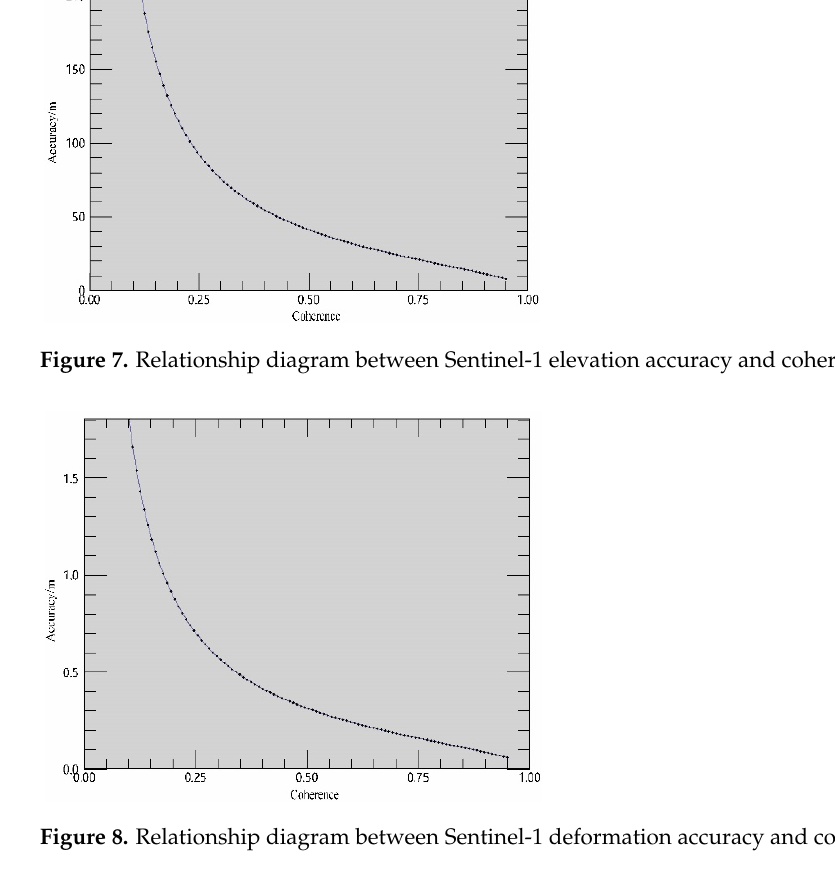
Figure 6. Baseline estimate result.